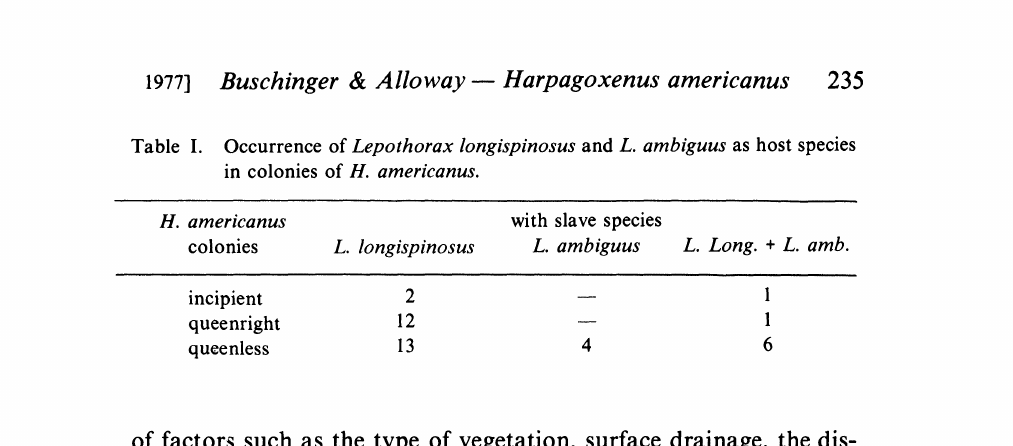
Buschinger & Alloway Harpagoxenus americanus 235 Occurrence of Lepothorax longispinosus and L. ambiguus as host species in colonies of H.